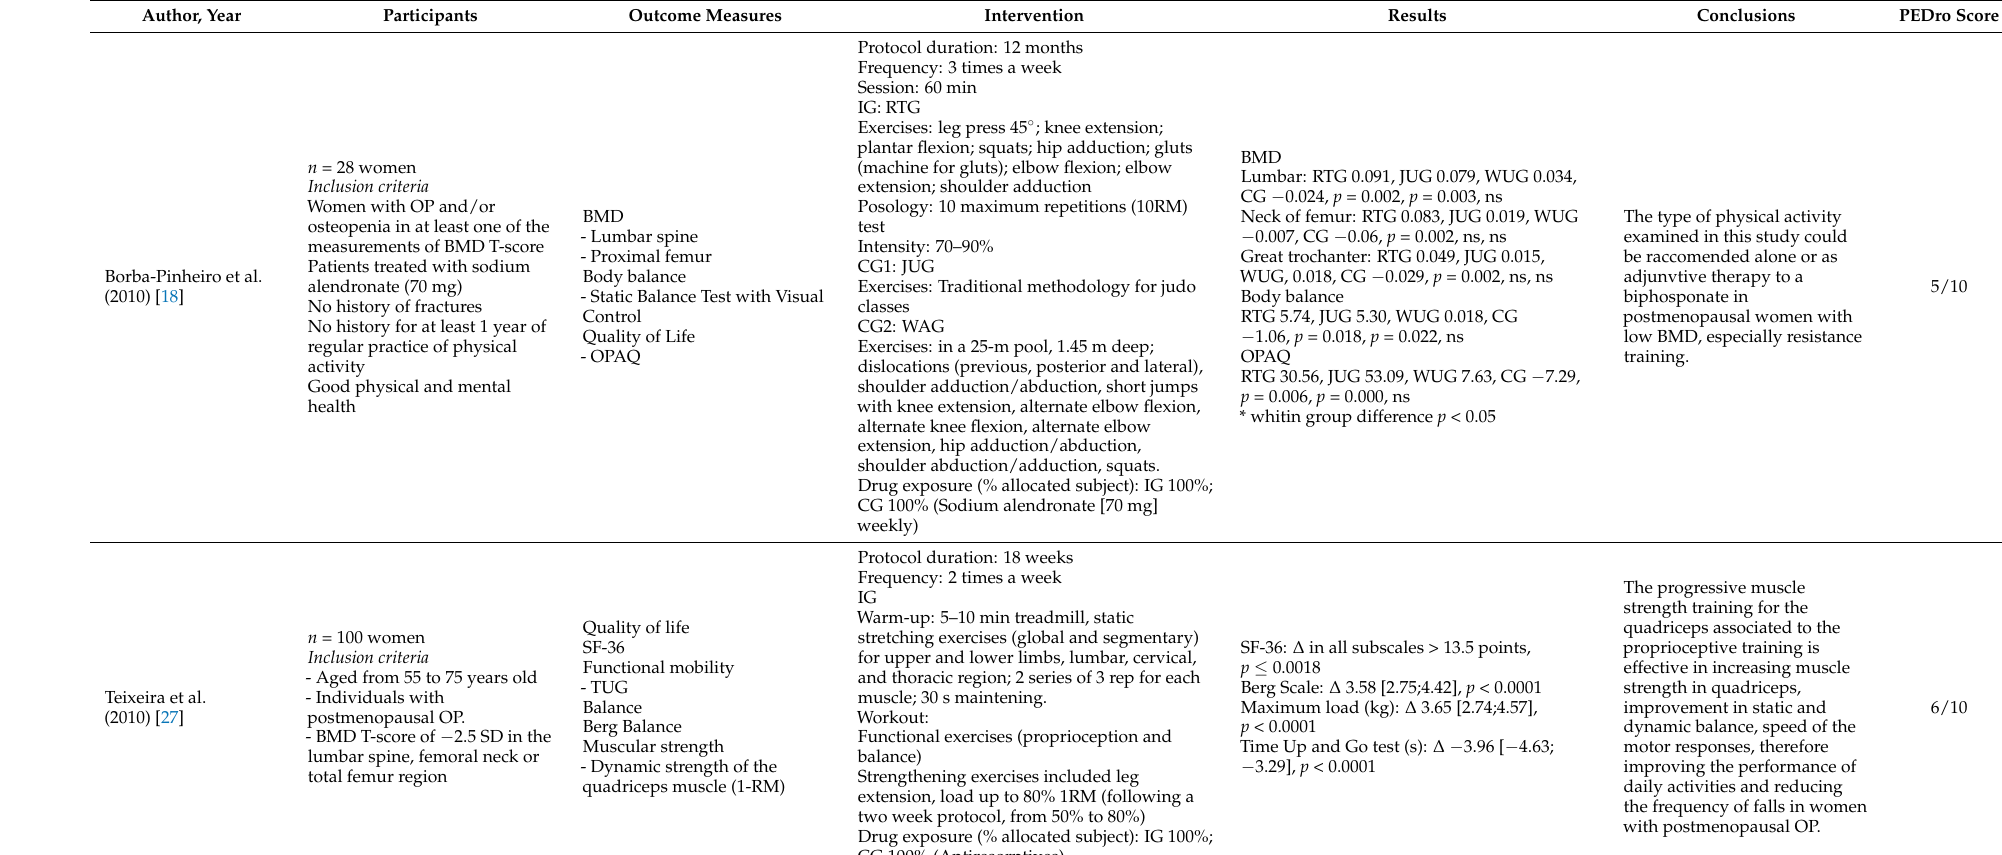
muscle; 30 s maintening.